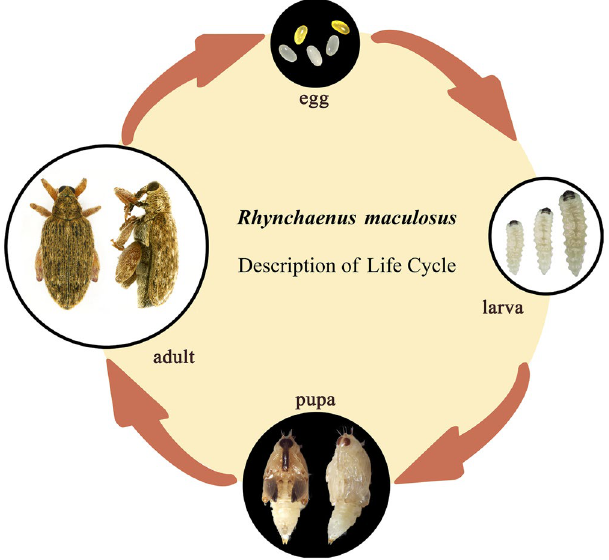
Figure 2. Life cycle of Rhynchaenus maculosus . Egg: early-stage eggs have a milky-white color whereas yellow indicates the late-stage; Larva: the three larval individuals from left to right indicate the 3 instars of the whole larval stage; Pupa: ventral view to the left and lateral view to the right; Adult: dorsal view to the left and the lateral view to the right.